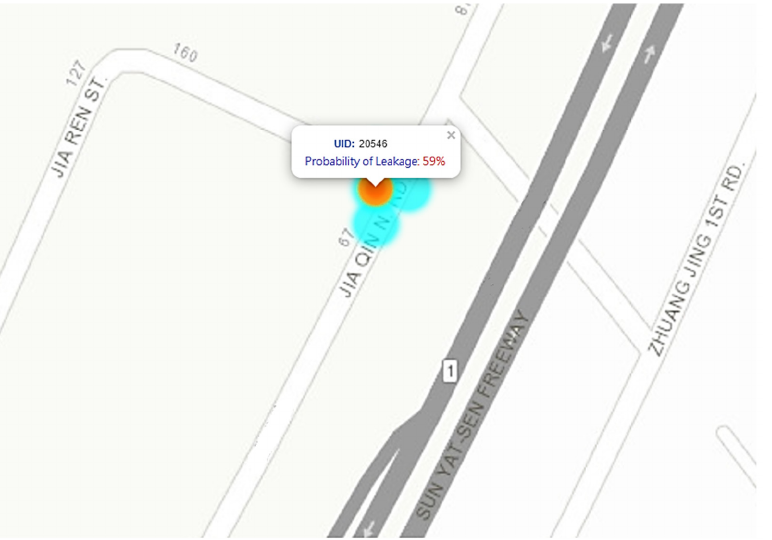
Figure 16. Leak detection personnel of Taiwan Water Corporation used localized AI water leakage diagnostic instruments to determine the scope of leakage.